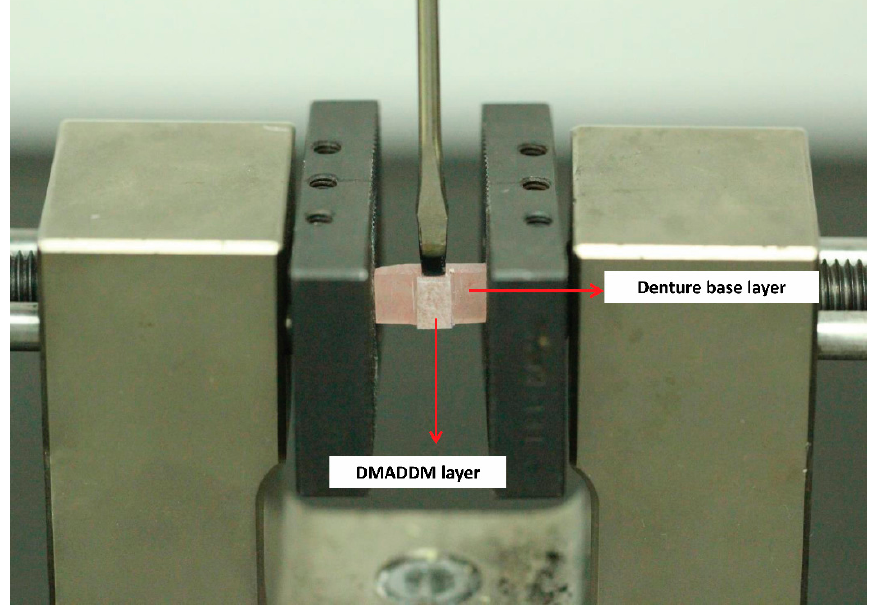
Figure 2. Sample clamped in Universal Testing Machine.